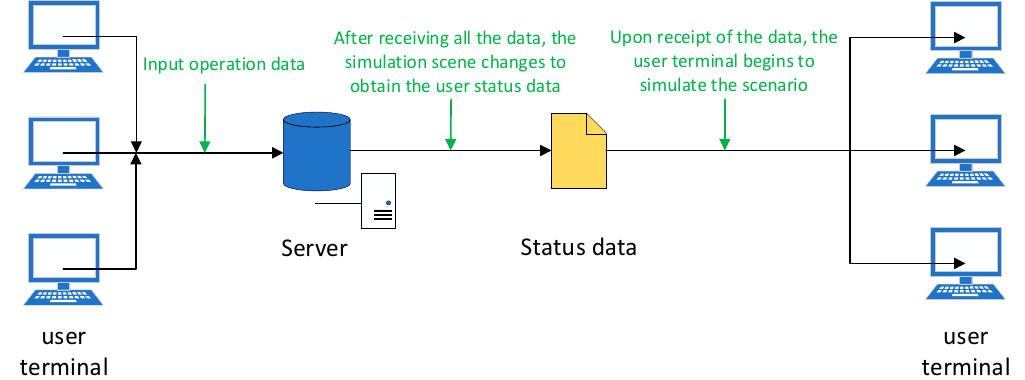
Figure 6. Schematic diagram of deterministic lockstep synchronization.